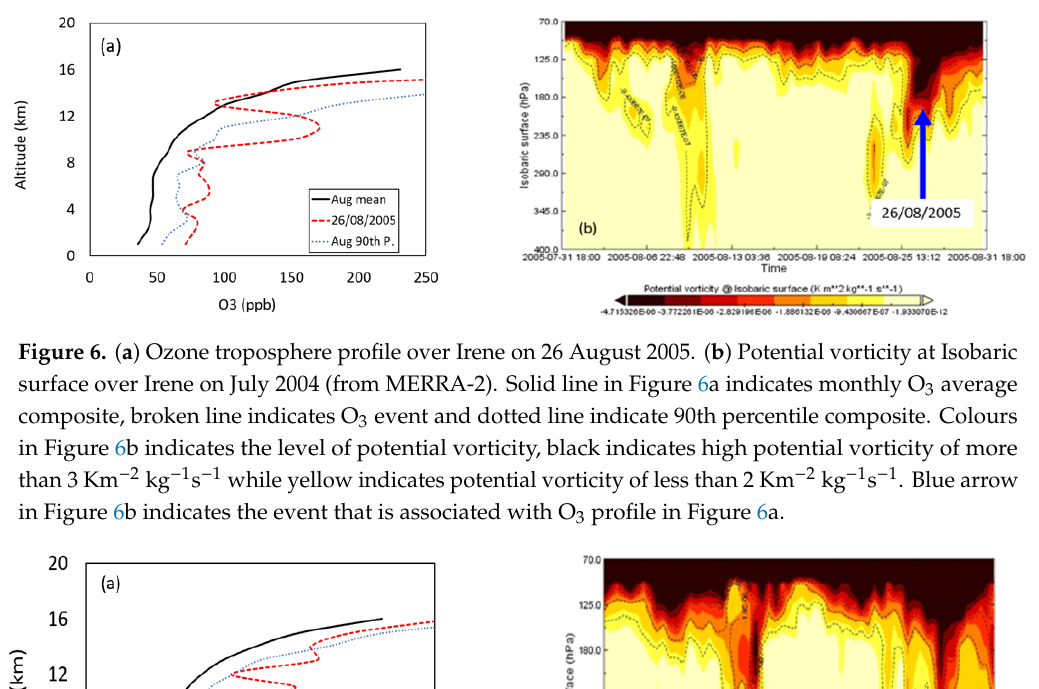
10 of 22 Figure 4. ( a ) Ozone troposphere profile over Irene on 07 July 2004. ( b ) Potential vorticity at Isobaric surface over Irene on July 2004 (from MERRA-2). Solid line in Figure 4a indicates monthly O 3 average composite, broken line indicates O 3 event and dotted line indicate 90 th percentile composite. Colours in Figure 4b indicates the level of potential vorticity, black indicates high potential vorticity of more than 3 Km −2 kg −1 s −1 while yellow indicates potential vorticity of less than 2 Km −2 kg −1 s −1 . Blue arrow in Figure 4b indicates the event that is associated with O 3 profile in Figure 4a. Figure 5 . ( a ) Ozone troposphere profile over Irene on 15 September 2004. ( b ) Potential vorticity at